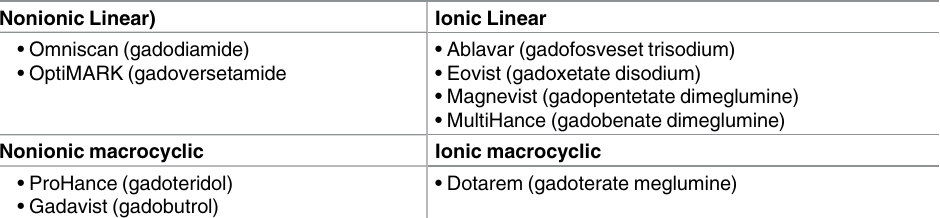
Table 2. GBCAs approved for clinical